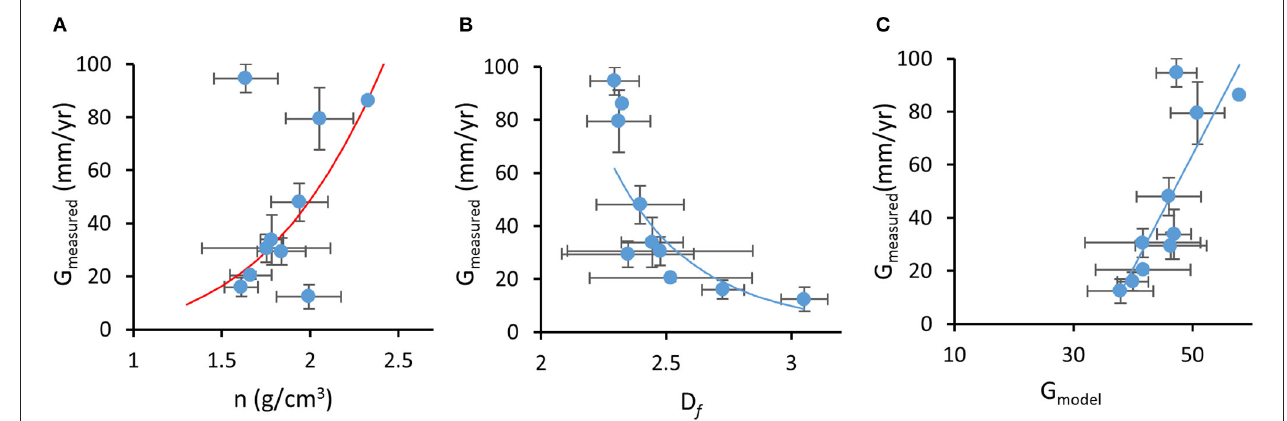
FIGURE 4 | Fractal coral growth model relating (A) measured growth (G) to measured skeletal density ( n ), where the red line represents model prediction, (B) measured growth to measured mass-fractal dimension (D f ), where the line represents power-law regression ( r 2 0.73), and (C) measured growth to model-predicted = growth, where the line represents linear regression ( r 2 0.67). Error bars represent standard =